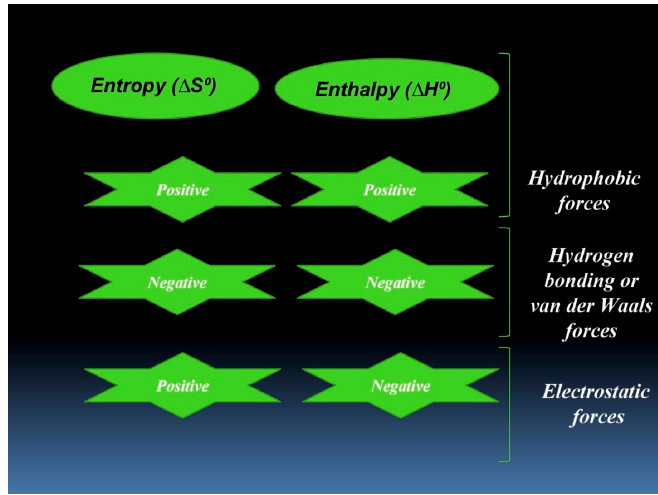
Figure 4. Graphical representation of the possible interaction forces depending upon thermodynamic parameters.